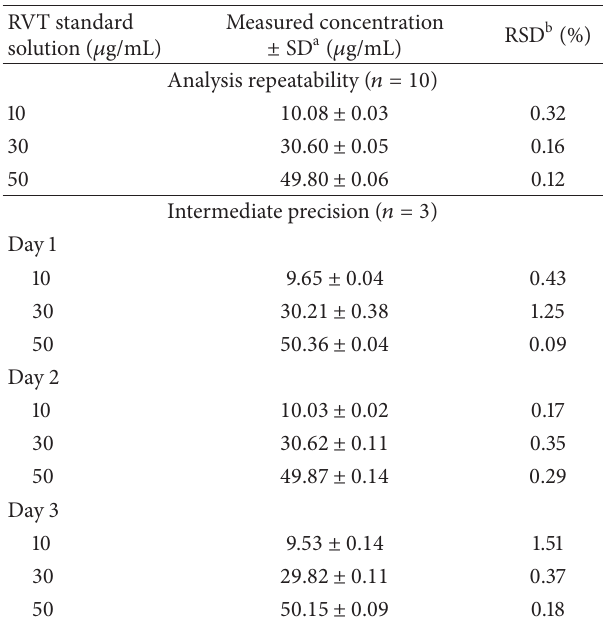
Table 2: Precision results for the different levels of RVT in standard